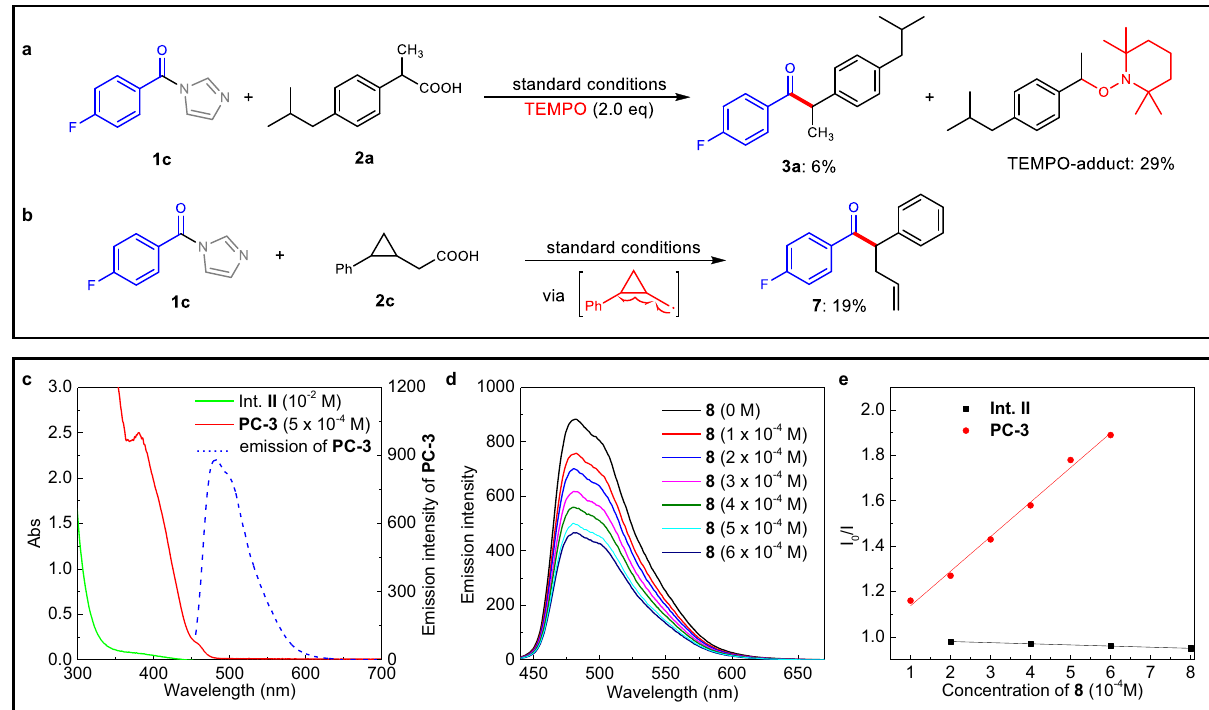
Fig. 6 Mechanistic studies. a Reaction in the presence of TEMPO (2,2,6,6-Tetramethylpiperidinooxy). b Radical clock reaction. c UV – Vis absorption spectra of Int. II and PC-3 . d Stern – Volmer quenching experiments between PC-3 and sodium carboxylate 8 . e Stern – Volmer quenching experiments between Int. II and sodium carboxylate 8 (black